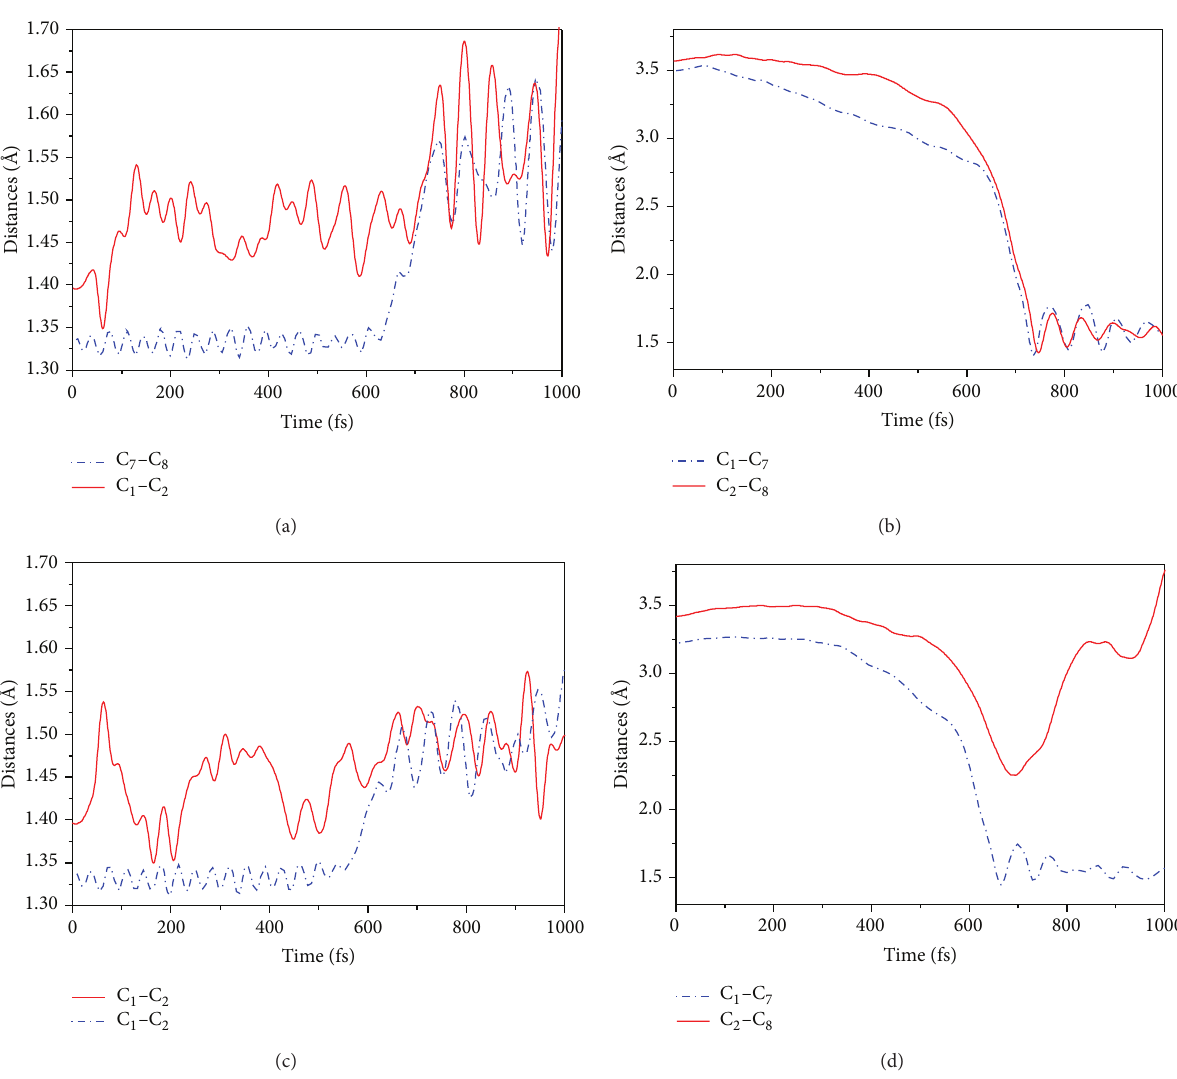
Figure 6: The variations of (a) C 1 –C 2 and C 7 –C 8 and (b) C 1 –C 7 and C 2 –C 8 distances with time of synchronous mode. (c) and (d) are these distances in asynchronous mode. Table 1: Energies and geometries of both synchronous and synchronous [2 + 2] photocycloaddition reactions. Structure